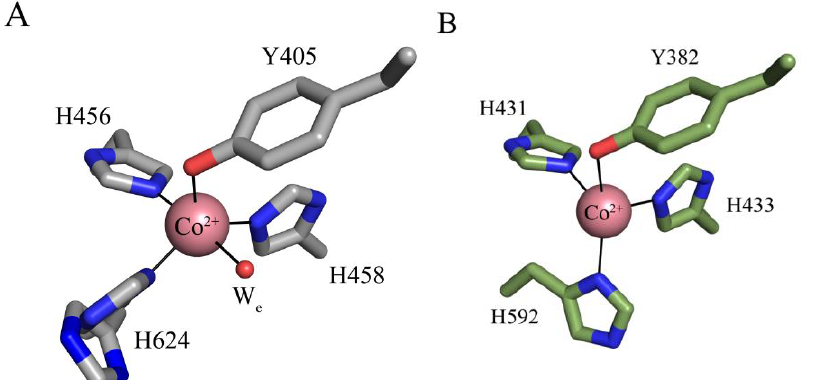
Figure 6. Active sites of ( A ) Co(II)-apoHPAO-1 (PDB code 3sxx) and ( B ) Co(II)-apoAGAO (PDB code 1wmp) [71,77]. Residues are drawn in stick and colored by atom type (apoHPAO1: carbon, grey; apoAGAO: carbon, green). Cobalt ions are drawn as pink spheres, and a water molecule as a small red sphere. Ligand-metal interactions are indicated by solid lines. Figure adapted from